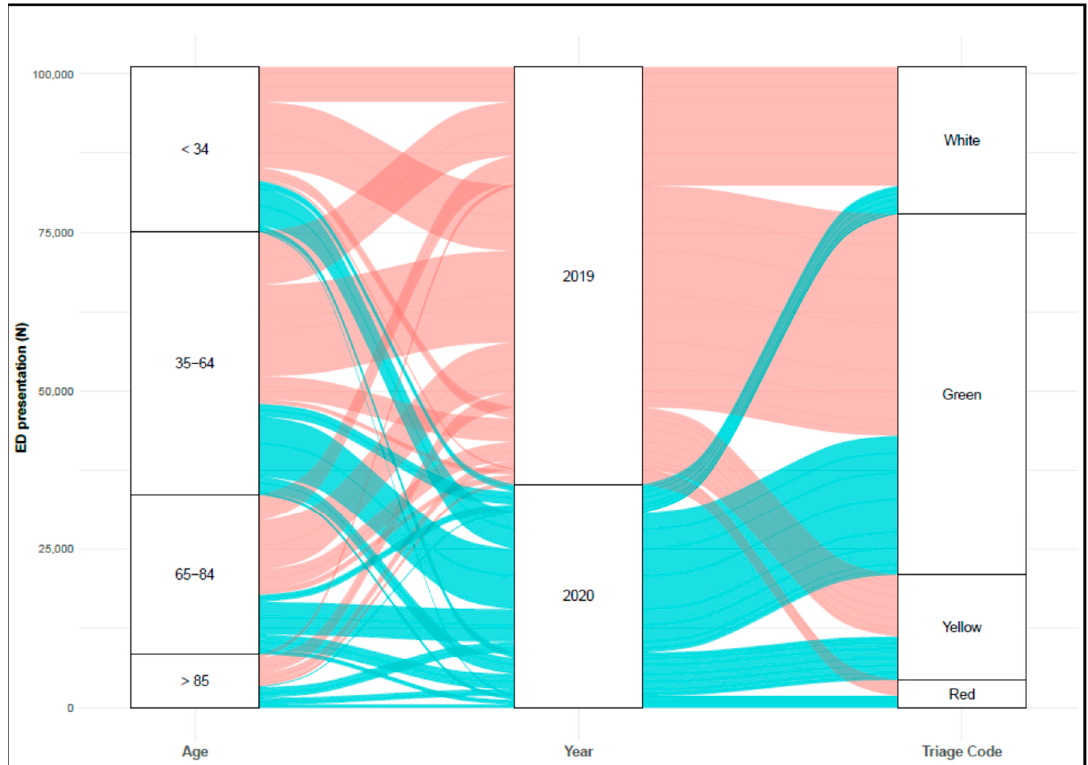
Figure 1. Alluvial plot for the number of ED presentations in 2019 and 2020. The height of the blocks represents the proportion of observations in that cluster, and the height of the stream field represents the proportion of observations contained in both blocks they connect. Stream field colors denote the years 2019 (pink) and 2020 (blue). The triage code denotes the classification of disease severity following the current Italian ED triage scoring system (white: no need for emergency treatment; green: need for fast treatment; yellow: severe condition; red: life-threatening condition).